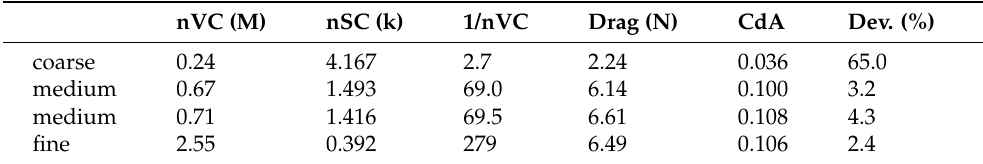
Table 2. Data used in mesh dependency study. nVC: number of volume cells (tets), nSC: number of surface cells (triangles) of cyclist’s